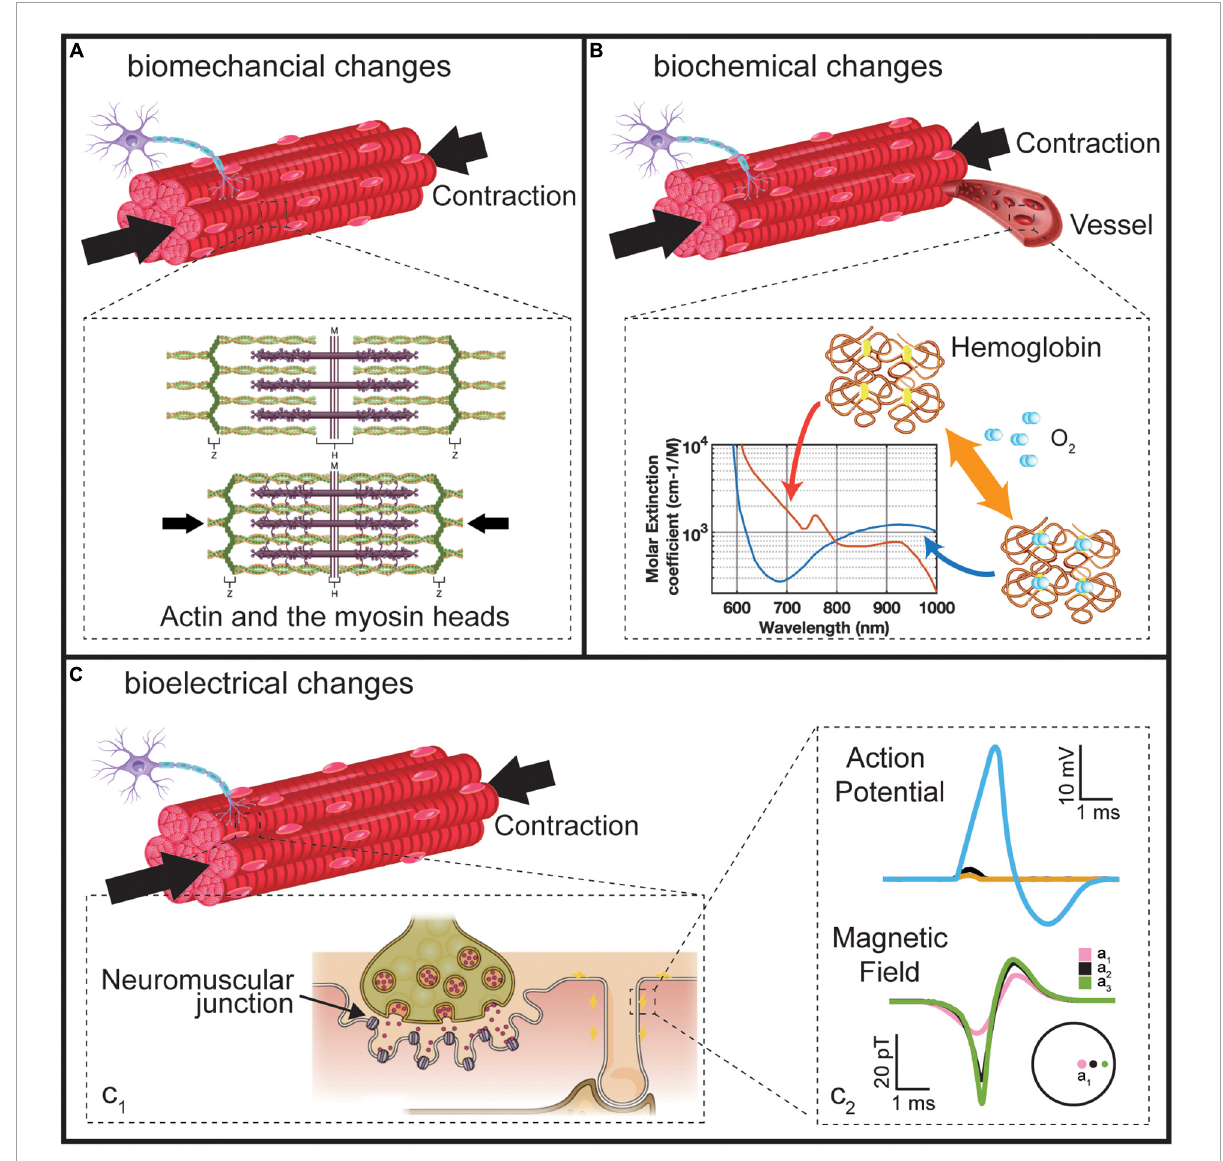
FIGURE2 Three changes during the muscle contraction. (A) The biomechanical changes. Reproduced under terms of the CC-BY license (OpenStax, 2022). Copyright 2022, OpenStax College, published by Rice University. (B) Biochemical changes. (C) Bioelectrical changes. Reproduced under terms of the CC-BY license (Ch. 10 Introduction – Anatomy and Physiology | OpenStax). Copyright 2022, OpenStax College, published by Rice